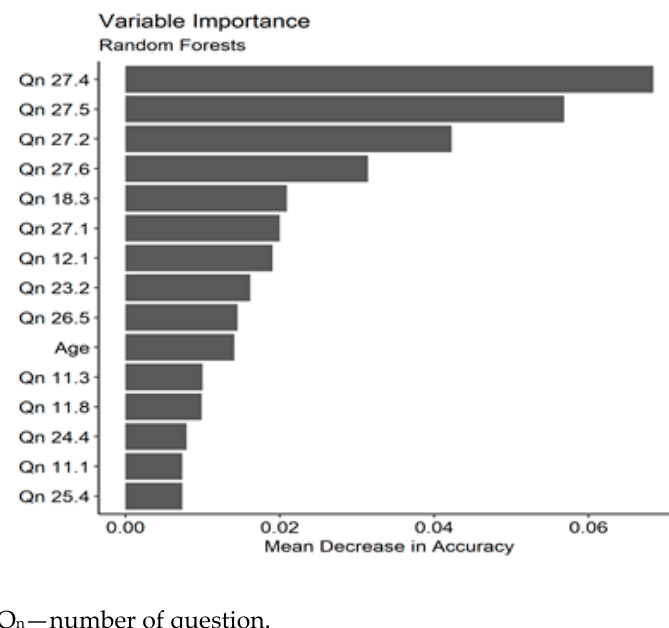
Table 5. Confusion matrix and model quality measures; test dataset. Test Data Set—Prediction of Electric Car Purchase